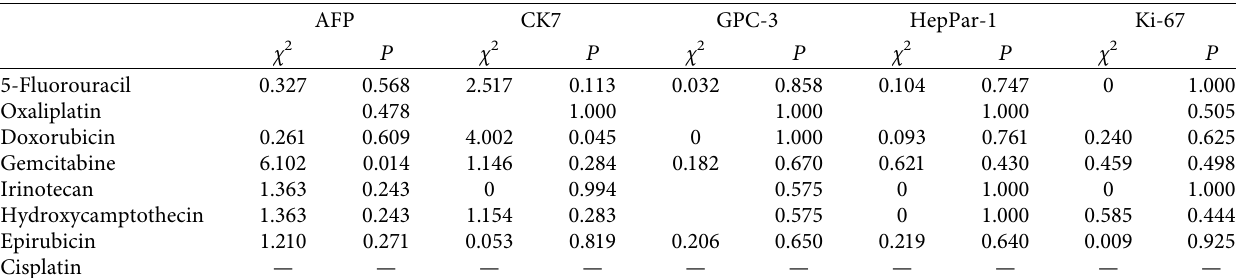
Table 4: Relationships between immunohistochemistry markers and cytotoxic drug